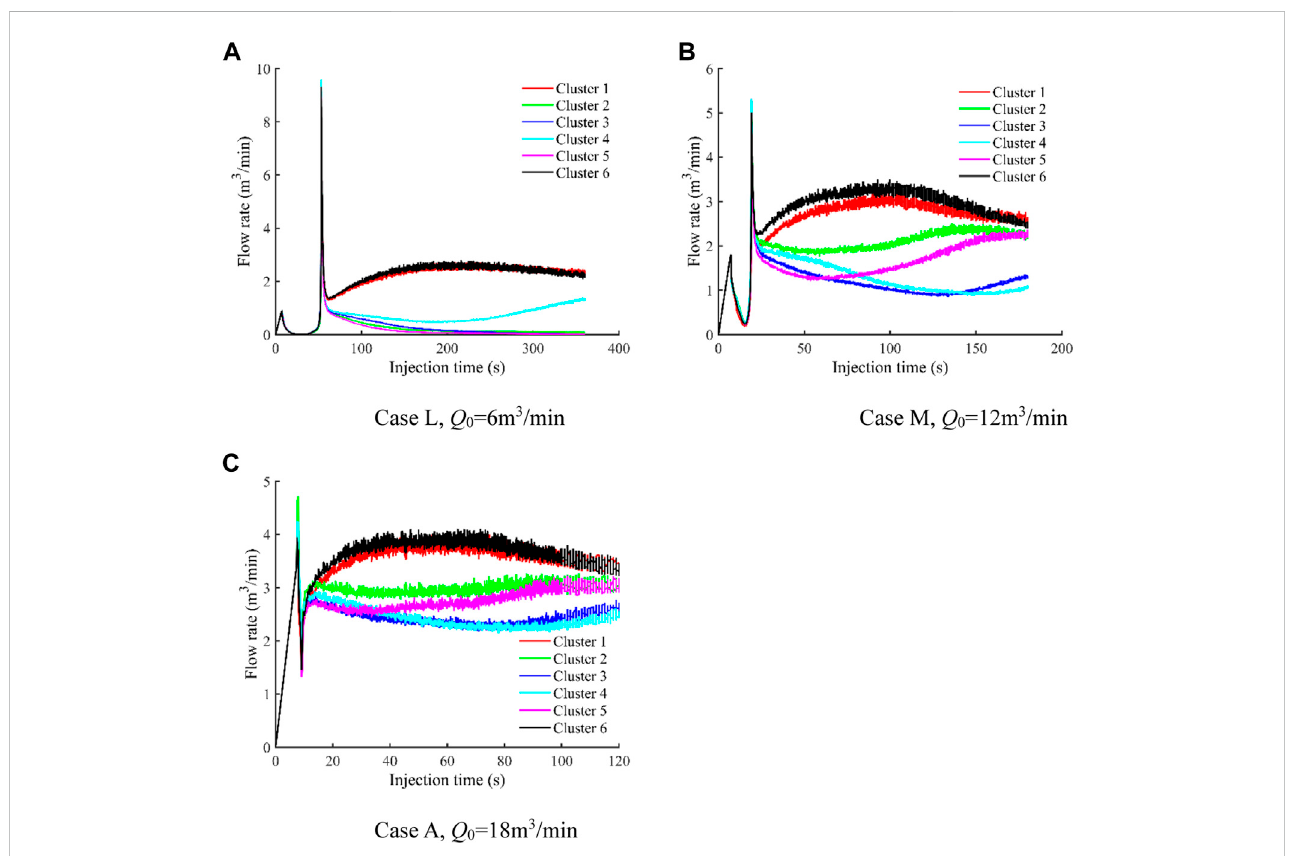
FIGURE 16 Flow rate into each cluster as a function of time for three cases with different injection rates. (A) Case L, Q 0 = 6 m 3 /min. (B) Case M, Q 0 = 12 m 3 /min. (C) Case A, Q 0 = 18 m 3 /min.